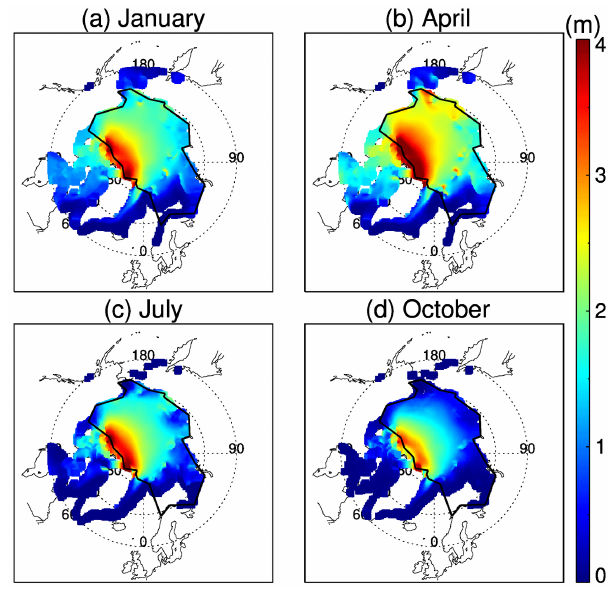
Figure A2. Derived climatological mean sea ice thickness distribu- tion in the Arctic from PIOMAS, 1984 to 2018.